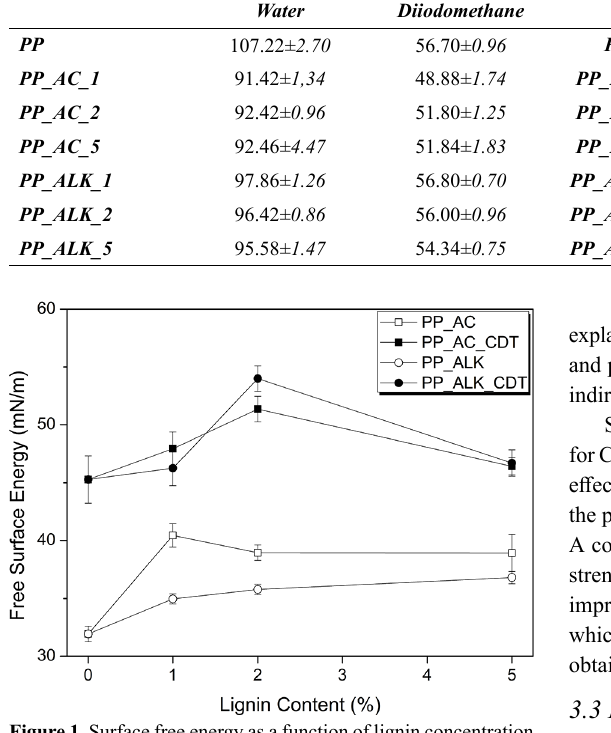
Table 3. Contact angle values using water and diiodomethane. Material